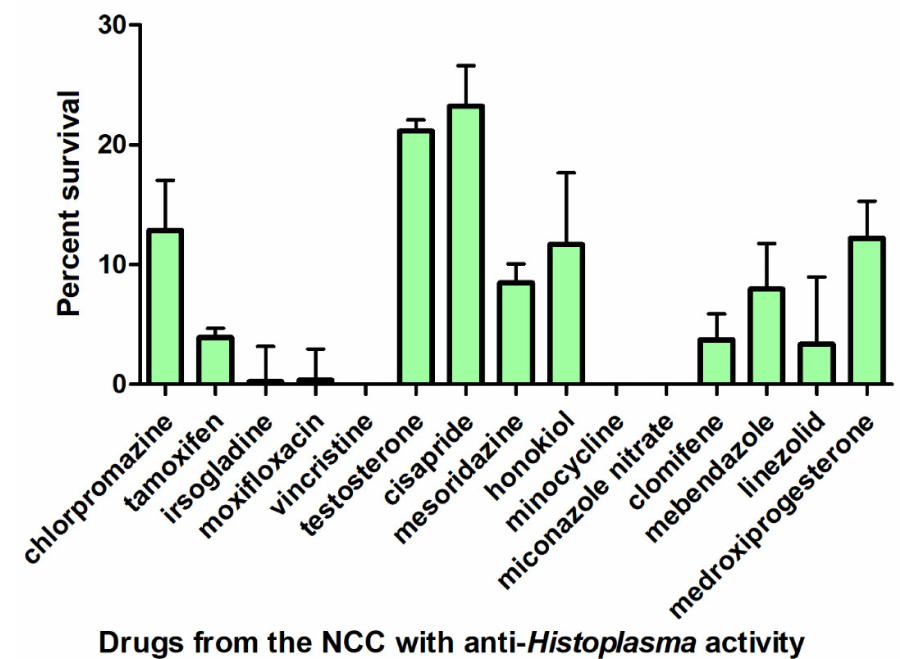
Figure 1. Antifungal activity of 15 drugs present in the NIH Clinical Collection (NCC) against the reference H. capsulatum G271B strain. Bars represent the mean and the standard deviation of the percent survivals determined in three independent experiments, as compared to the drug-free control wells. Only NCC drugs presenting less than 50% survival are